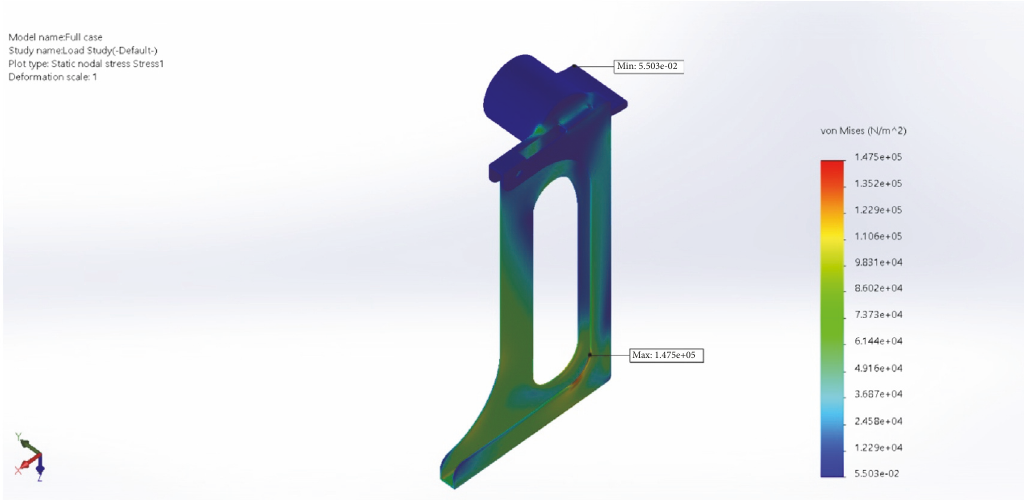
Figure 6: Static stress plot (the force is transmitted equally towards all features of the design).